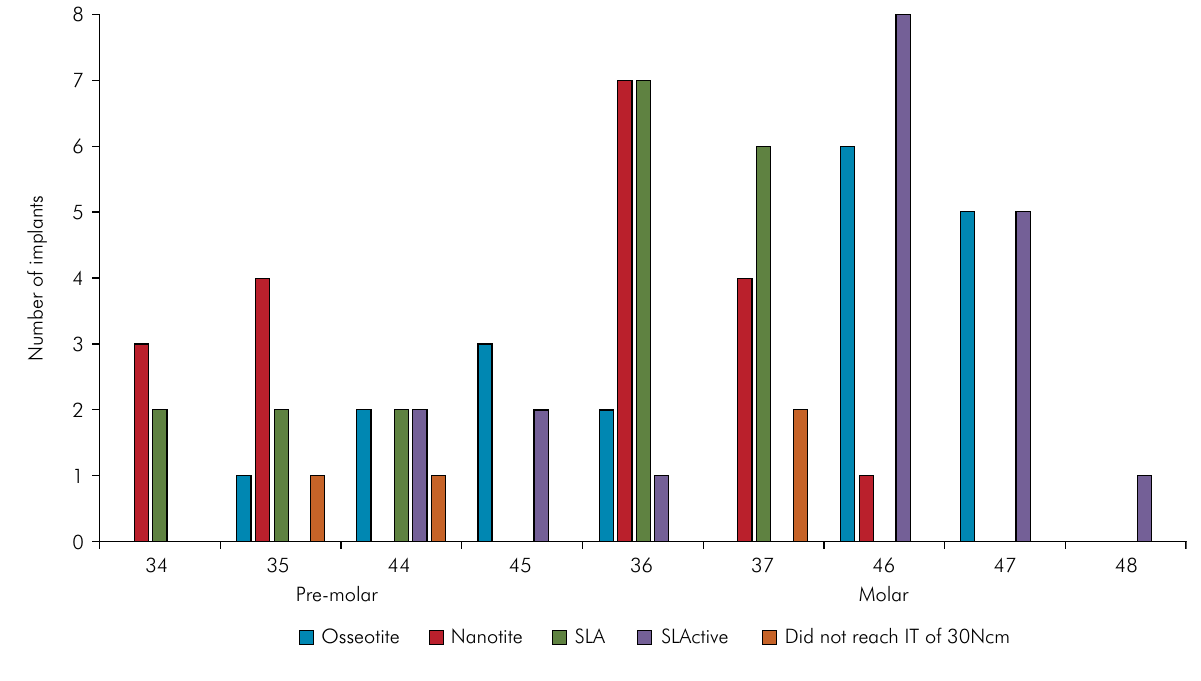
Figure 3. Distribution of the implant sites.